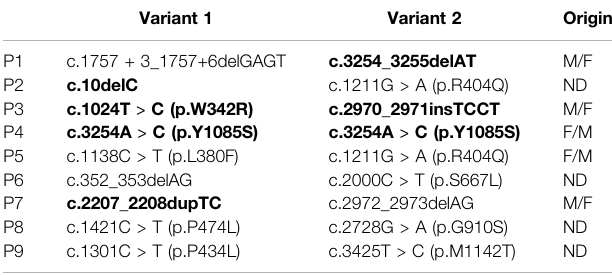
TABLE 1 | Molecular fi ndings in NPC1 (NM_000271) of 9 patients with neonatal